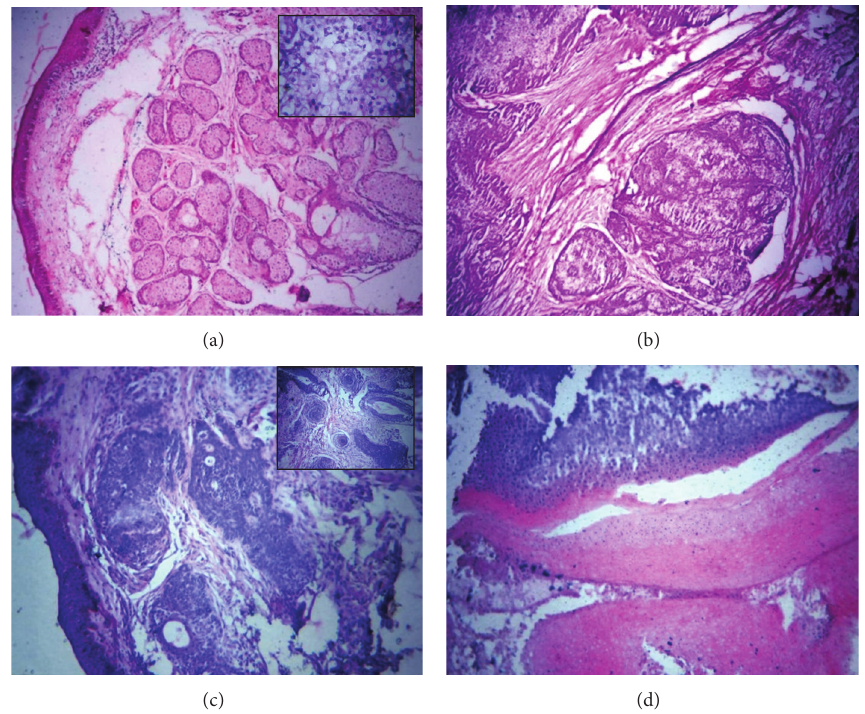
Figure 2: (a) Sebaceous adenoma: well-circumscribed tumor composed of sebaceous lobules of varying sizes and shapes (H&E × 100). Undifferentiated basaloid cells at the periphery while mature sebaceous cells were seen towards their center (Inset H&E × 400). (b) Sebaceous carcinoma: lobular arrangements of cells consist of small undifferentiated eosinophilic cells and large cells with clear to foamy cytoplasm. (H&E × 100). (c) Trichofolliculoma: dermis showing multiple cysts filled with keratin and lined by squamous epithelium (H&E × 100) and multiple cysts filled with keratin and lined by squamous epithelium. (Inset H&E × 100). (d) Pilomatricoma: Eosinophilic shadow cells predominantly and few basophilic cells with keratinization. (H&E × 100).